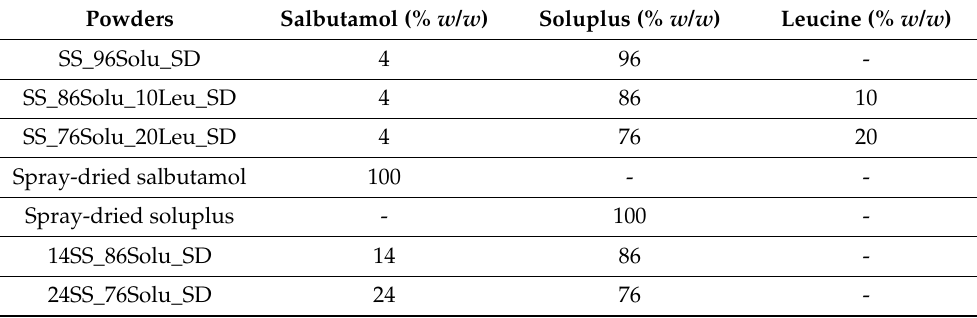
Table 1. The composition of the different spray-dried powders (4% salbutamol/96% soluplus (4SS_96Solu_SD), 4% salbutamol/86% soluplus/10% leucine (4SS_86Solu_10Leu_SD), and 4% salbu- tamol/76% soluplus/20% leucine (4SS_76Solu_20Leu_SD, spray-dried salbutamol, and spray-dried soluplus). 14SS_86Solu_SD and 24SS_76Solu_SD represent powders containing salbutamol and soluplus in the ratios of 14:86 and 24:76,